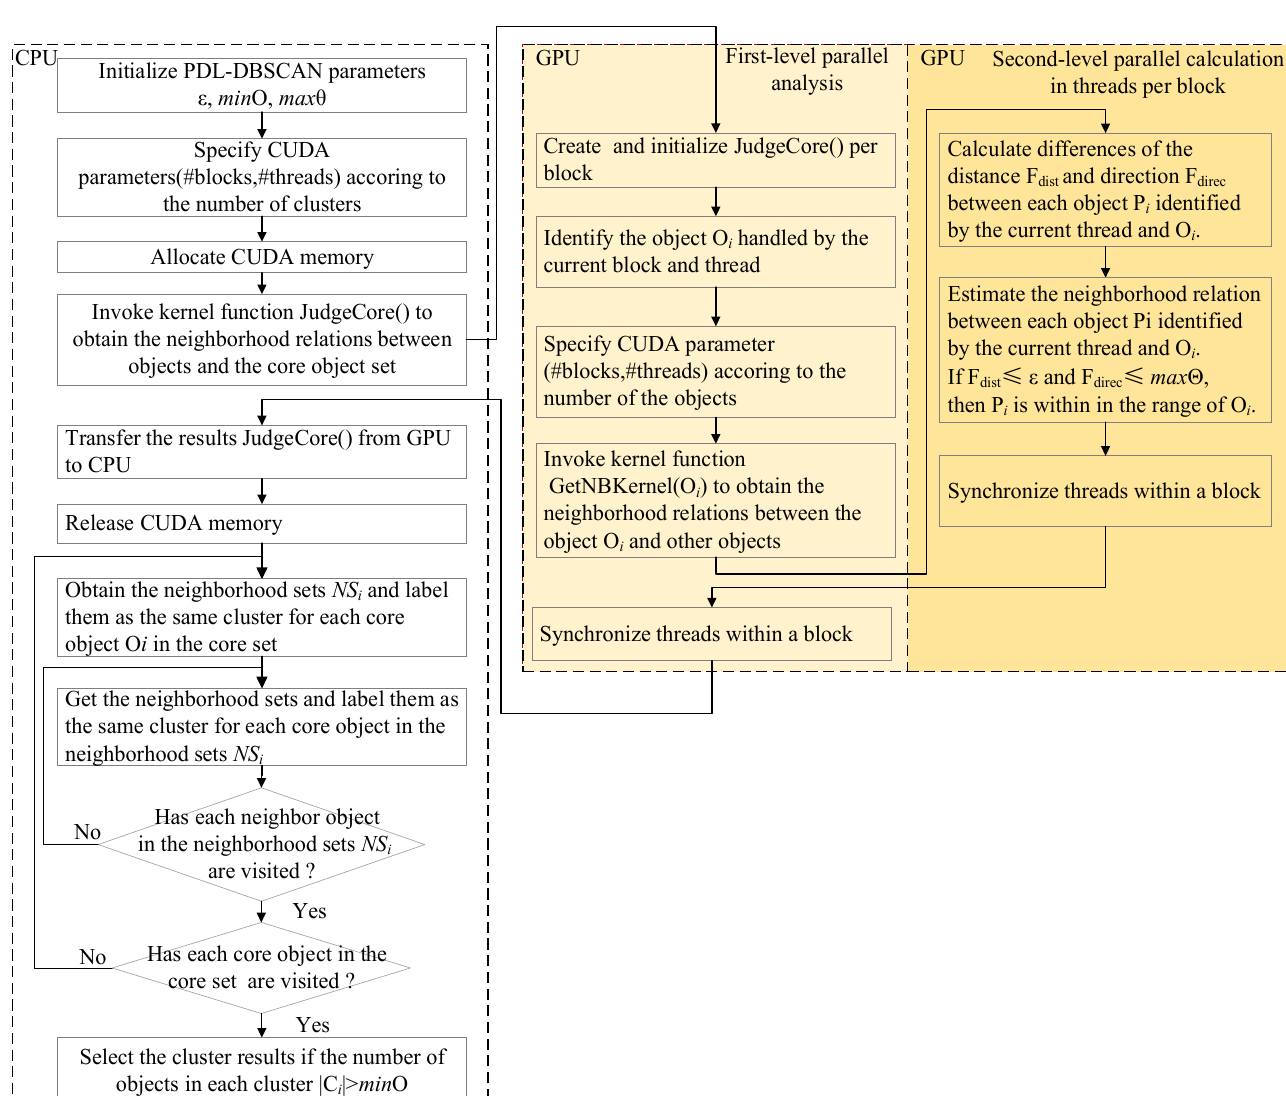
Figure 3. The flow chart of PDL-DBSCAN algorithm.